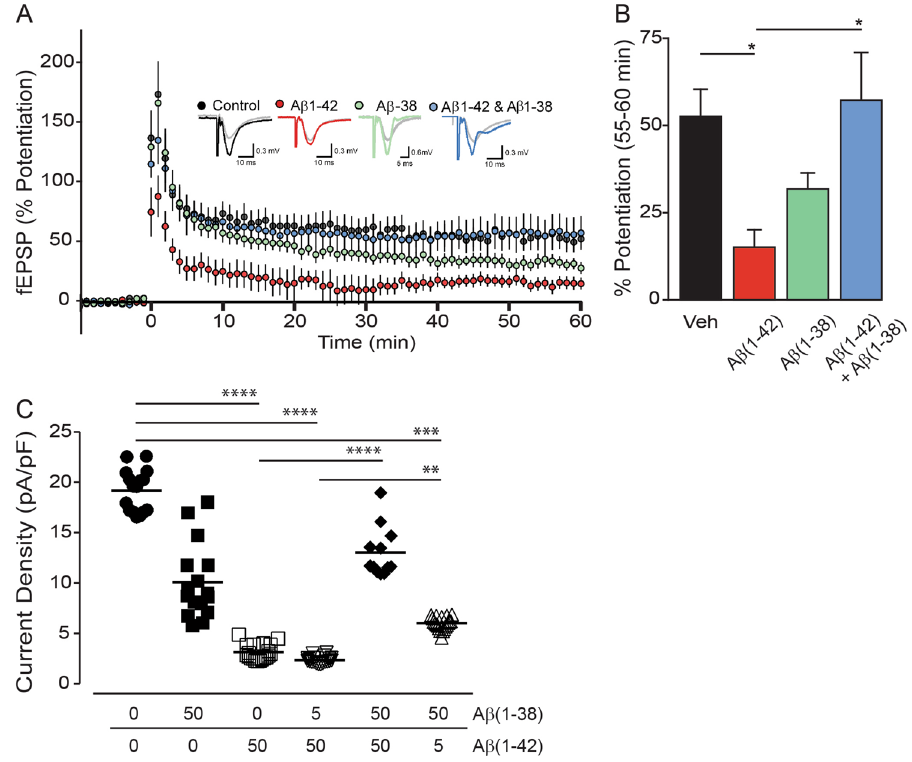
Figure 5. Aβ(1–38) rescues the deficit caused by application of Aβ(1–42) in electrophysiological paradigms. ( A ) Long-term potentiation (LTP) graph showing the percent potentiation (mean ± sem) following theta burst LTP in control (black; n = 10), Aβ(1–42) (red; n = 8), Aβ(1–38) (green; n = 6), and Aβ(1–42) + Aβ(1–38) (blue; n = 7) conditions (all peptides at 500 nM). Theta burst stimulation was applied at time = 0 min. Representative fEPSP responses obtained during the baseline (grey traces) and 55–60 min following LTP induction (black, red, blue and green traces) are shown for each condition. ( B ) Bar graph showing the percent potentiation (mean ± sem) 55–60 min post-LTP induction. *: P < 0.05. ( C ) Average current densities (± sem) from whole cell voltage-clamp recordings in primary hippocampal neurons exposed to Aβ(1–38) and Aβ(1–42) (in µM, 24 h). Cells were held at -60 mV and currents were elicited by voltage ramps, e.g. , step depolarized between -80 and + 100 mV (in 20 mV increments). Current density was measured at 0 and 20 mV, 100 ms after the voltage step. Currents were divided by cell capacitance and reported as current densities (pA/pF). **: P < 0.01; ***: P < 0.001; ****: P < 0.0001 between indicated